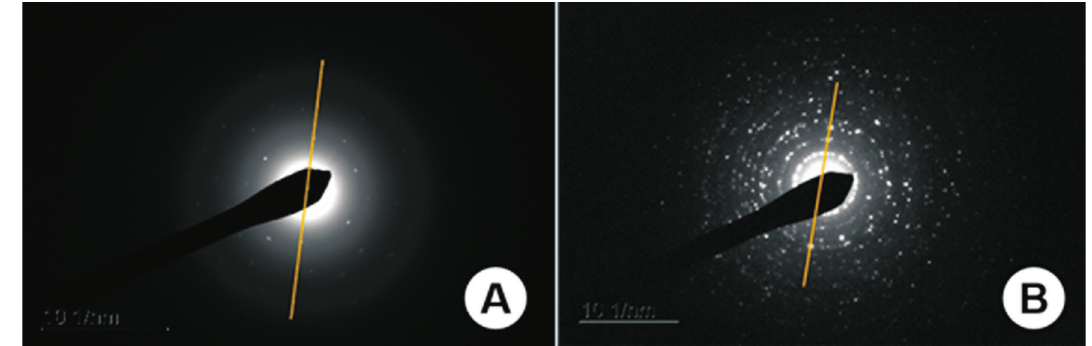
Figure 5 - Selected area electron diffraction (SAED) pictures used in the calculation of interplanar distances. (A) TiO 2 in brookite phase inside the roots of A. cepa . (B) TiO 2 in anatase phase in nanopowder form used in this